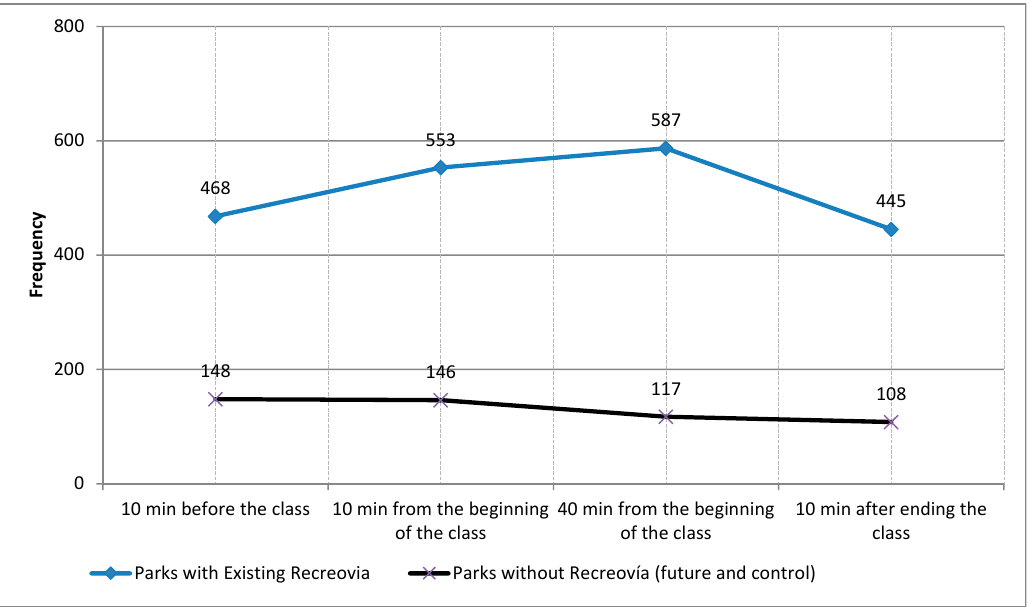
Figure 5. Number of participants observed in the potential target areas for aerobics in parks before, during and after the Recreovía park program (existing Recreovía vs. no Recreovía program) in Bogotá, Colombia, 2013.